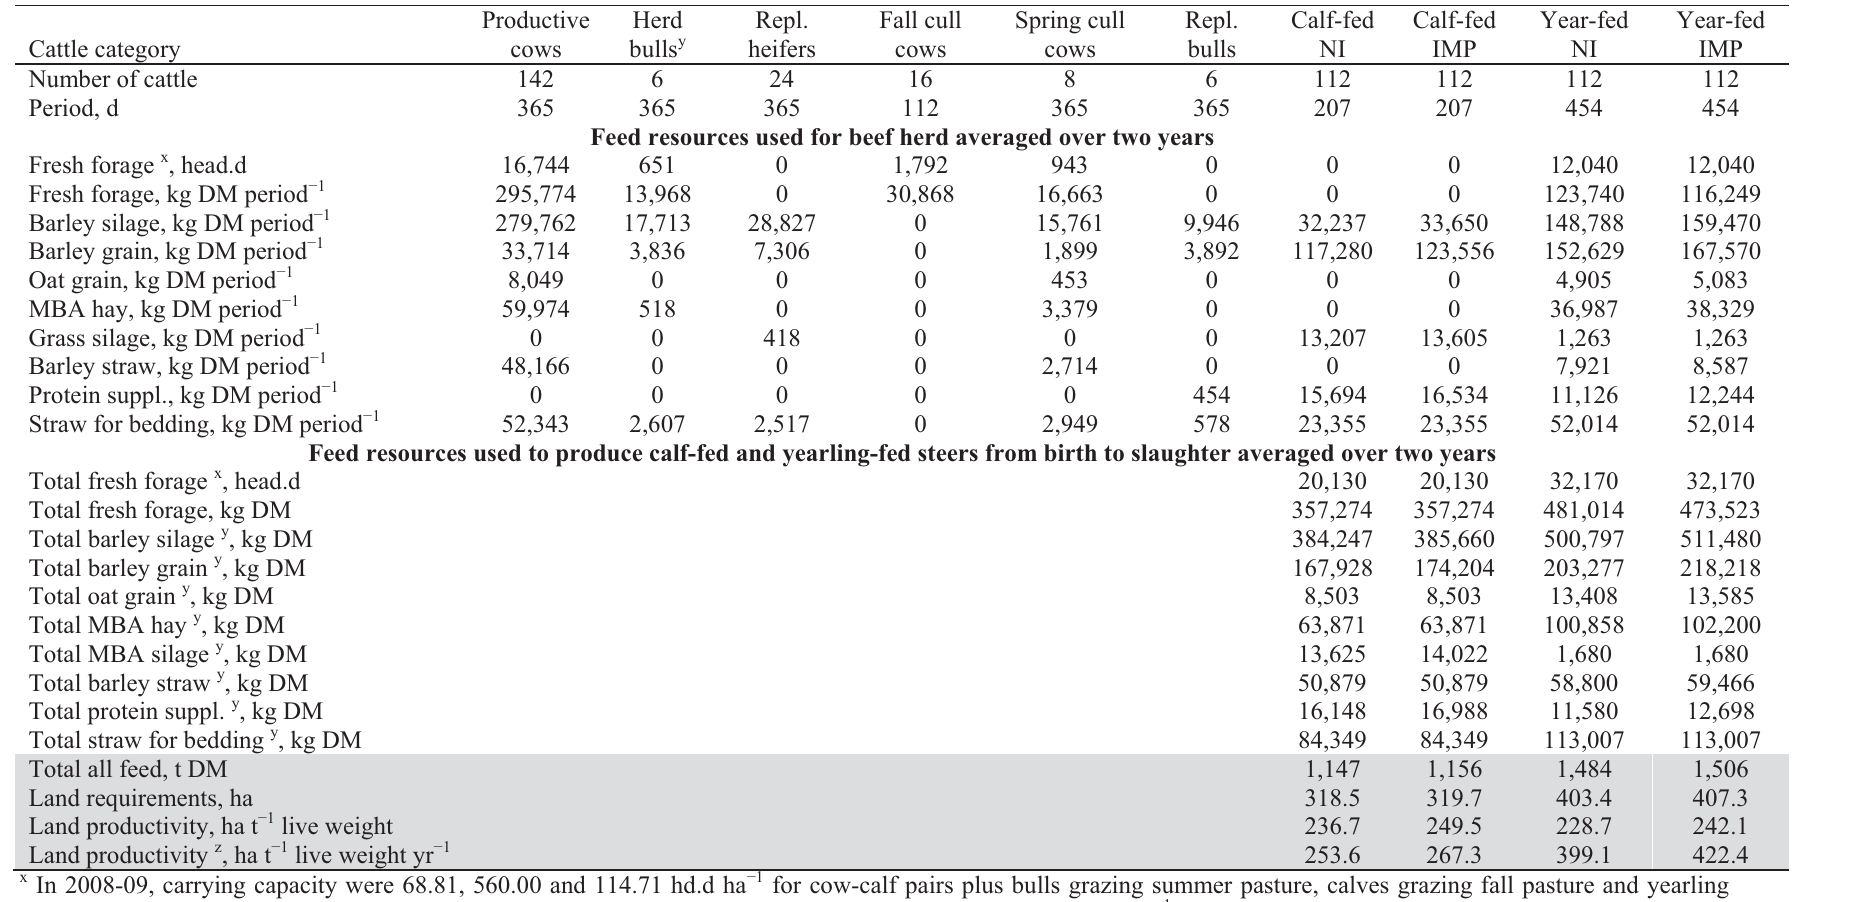
Productive Herd Repl. Fall cull Spring cull Repl. Calf-fed Calf-fed Year-fed Year-fed cows bulls y heifers cows cows bulls NI IMP NI IMP 142 365 365 365 365 454 Feed resources used for beef herd averaged over two years